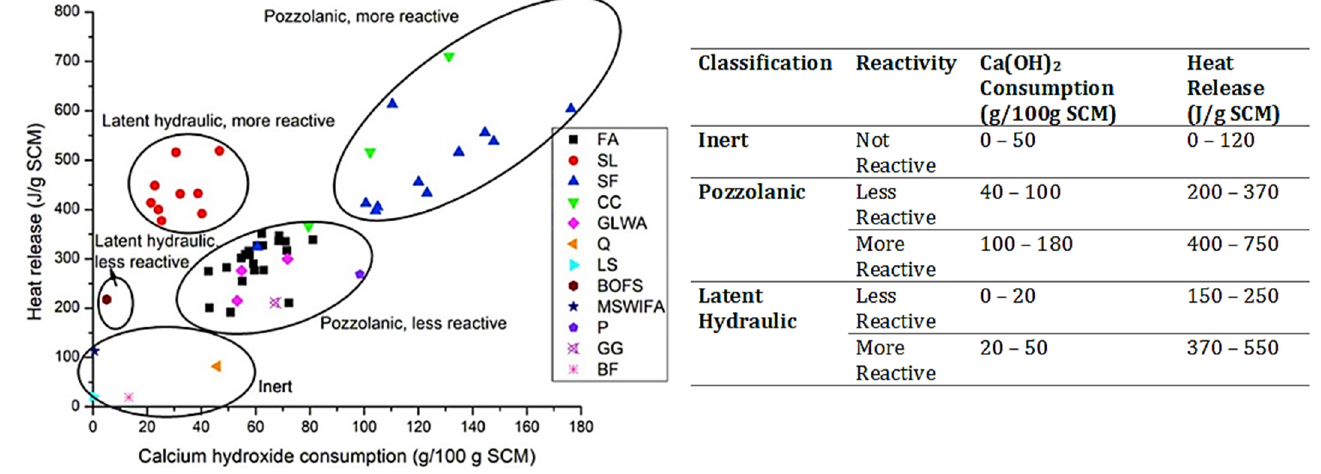
Figure 7. Classification of SCMs by plotting the heat release against Ca(OH) 2 consumption [229] (FA = Class C and Class F fly ash; SL = ground granulated blast furnace slags; SF = silica fume; CC = calcined clay; GLWA = ground lightweight aggregate; Q = quartz; LS = ground limestone; BOFS = basic oxygen furnace slag; MSWIFA = municipal solid waste incineration fly ash; P = ground pumice; GG = ground glass; BF = basalt fines).